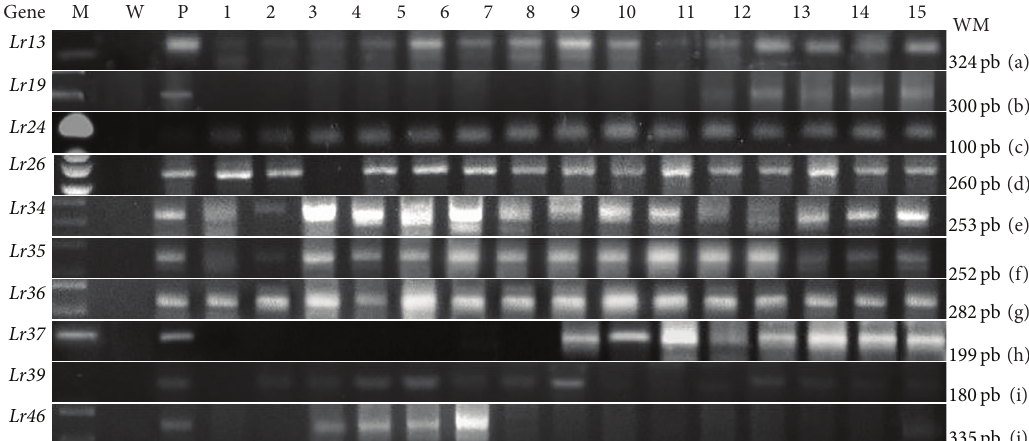
Figure 1: PCR amplification of 15 cultivars genomic DNA using ten Lr molecular marker. Lane M, 100pb marker; lane W, water as negative control; P, positive control; lane 1 Giza 163 cv, lane 2 Giza 164; lane 3, Giza 165; lane 4, Giza 167; lane 5, Giza 168; lane 6, Sakha 8; lane 7, Sakha 61, lane 8, Sakha 69; lane 9, Sakha 92; lane 10, Sakha 94; lane 11, Sids 1; lane 12, Sids 12; lane 13, Gemmeiza 7; lane 14, Gemmeiza 9, lane 15,